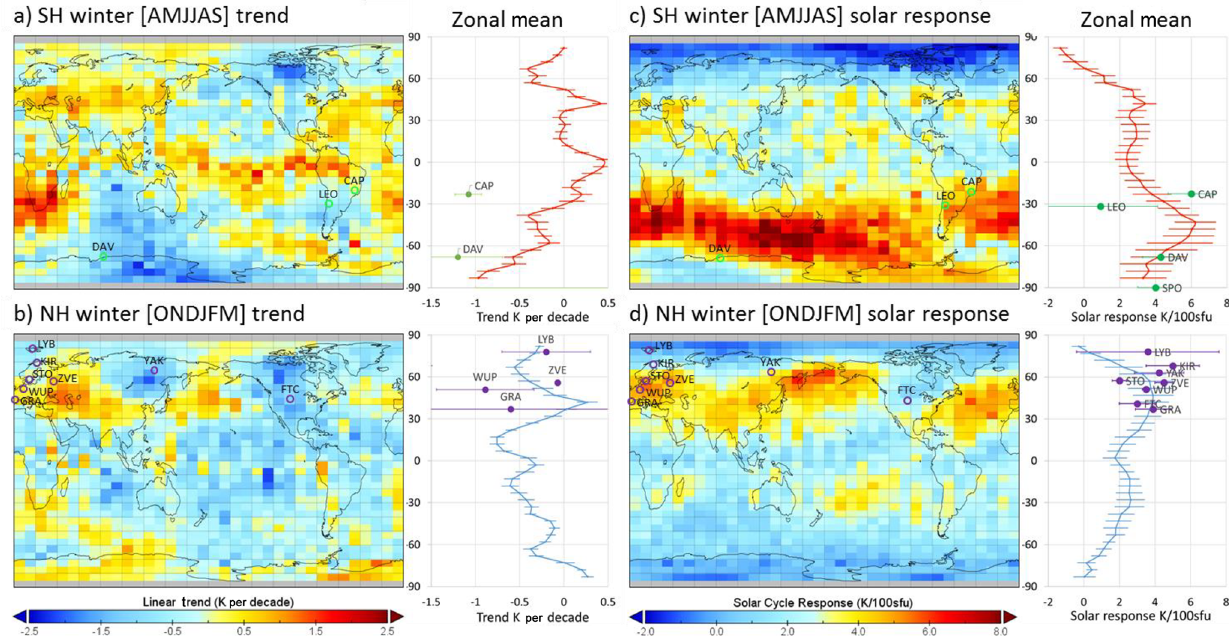
Figure 6. Global temperature trends (a, b) and solar cycle responses (c, d) , together with their corresponding zonal means determined from 14 years of MLS v4.2 pressure level 0.0046hPa (hydroxyl layer equivalent), averaged into a 5 ◦ latitude × 10 ◦ longitude grid, and over Southern Hemisphere winter months (AMJJAS; a, c ) compared to Northern Hemisphere winter months (ONDJFM; b, d ). The linear trend and solar cycle response coefficients have been derived individually for each grid box from Aura/MLS over 14 years with no lag. Station locations indicate the Aura/MLS comparison, with ground-based observations of long-term trend and solar response given in Table 1. Table 1. A comparison of solar cycle response and temperature trend observations from the ground-based OH observer network with updates since 2011 where available. Trend Solar response Site Data span K per decade K per 100sfu